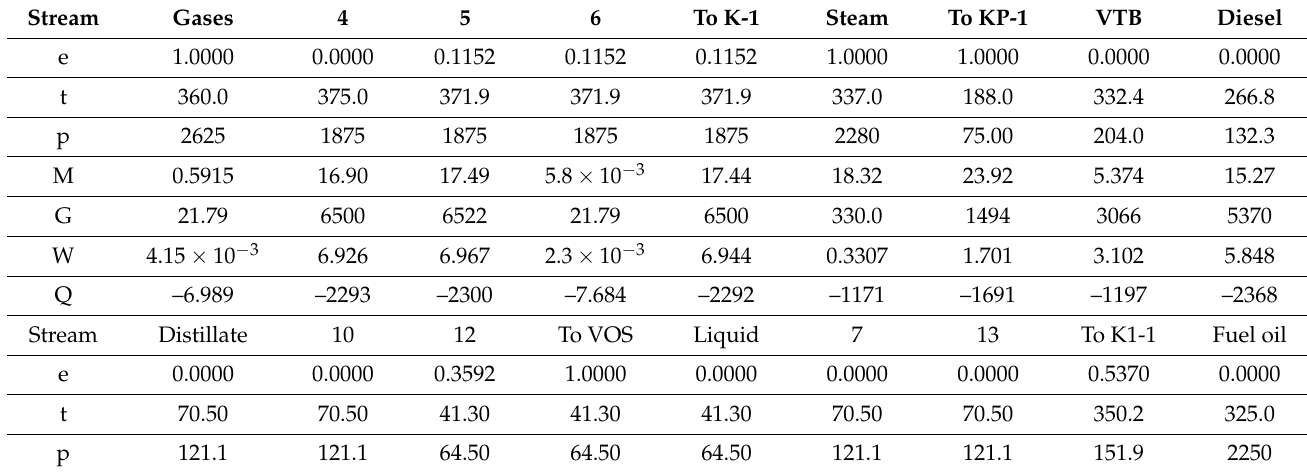
Table 14. Calculation results (mode